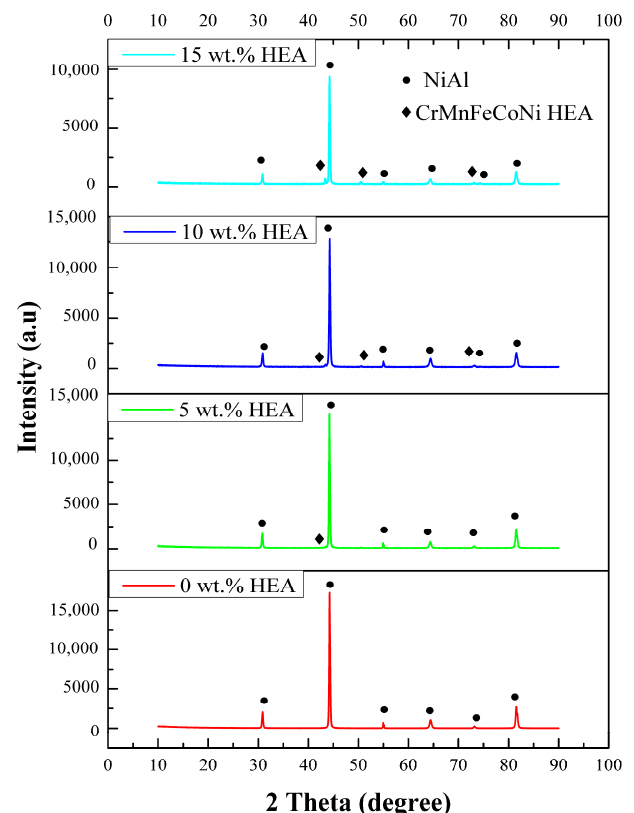
Figure 2. XRD patterns of the composites after sintering.